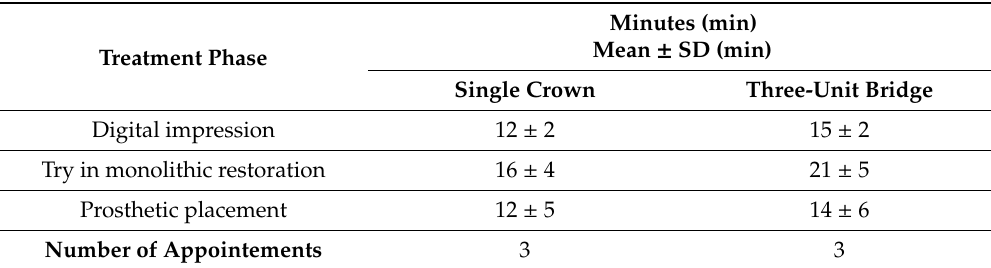
Table 4. Time e ffi ciency (digital